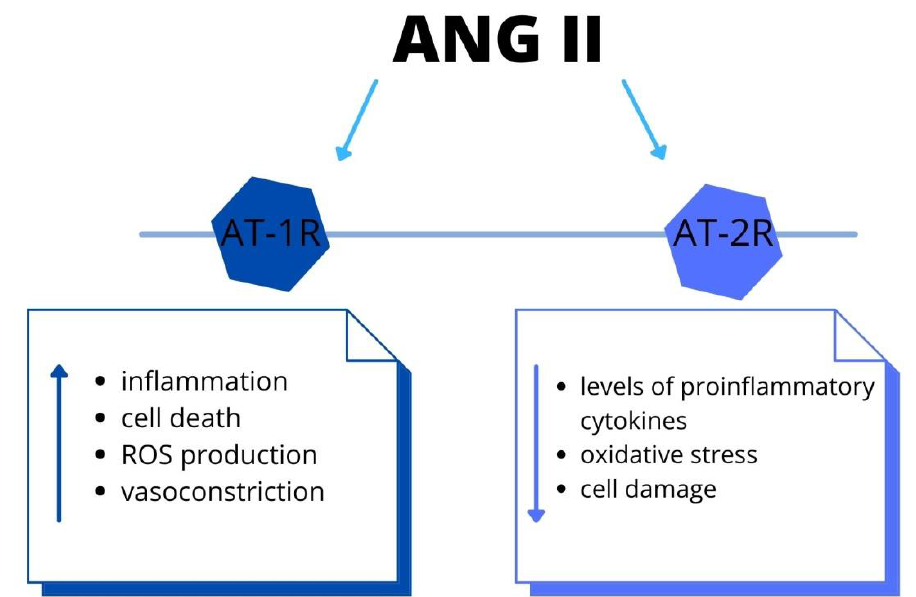
Figure 3. The RAAS system: the biological effects via angiotensin II-type 1 and type 2 receptors activation. Both systemically and locally produced Ang II bind to AT-1R and promote inflammation and cell death. Recent studies have shown that Ang II-induced activation of AT-2R and elicits the opposite functions to those of AT-1R. Abbreviations: Ang II-angiotensin II, AT-1R-Ang II type 1 receptor, AT-2R-Ang II type 2 receptor, ROS-reactive oxygen species.